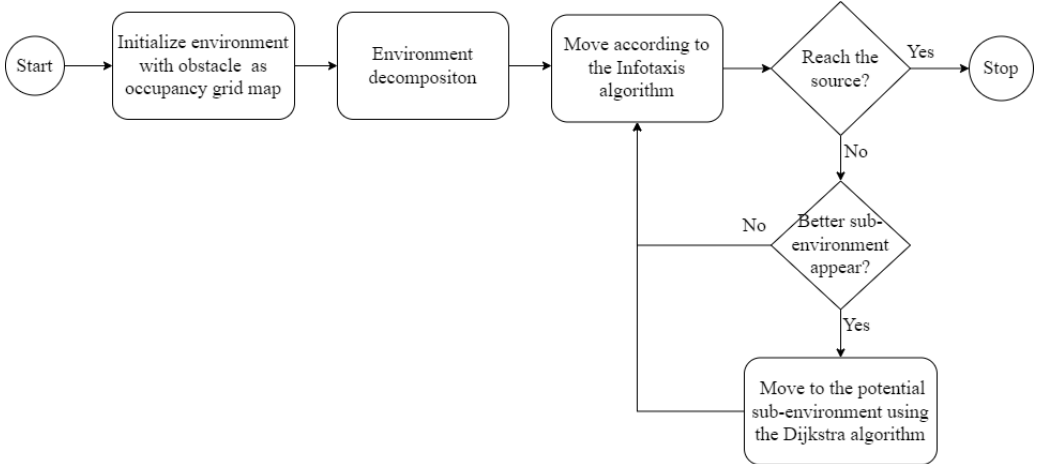
Figure 4. Multiple resolution grid maps are used for multiple planning algorithms in the odor source localization (OSL) task.